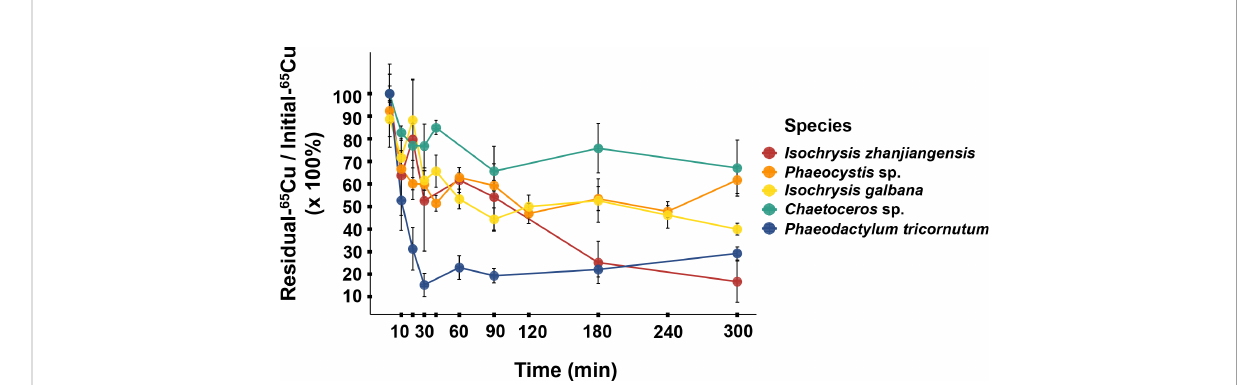
FIGURE 5 Retention of Cu in rotifers after pulse feeding different phytoplankton